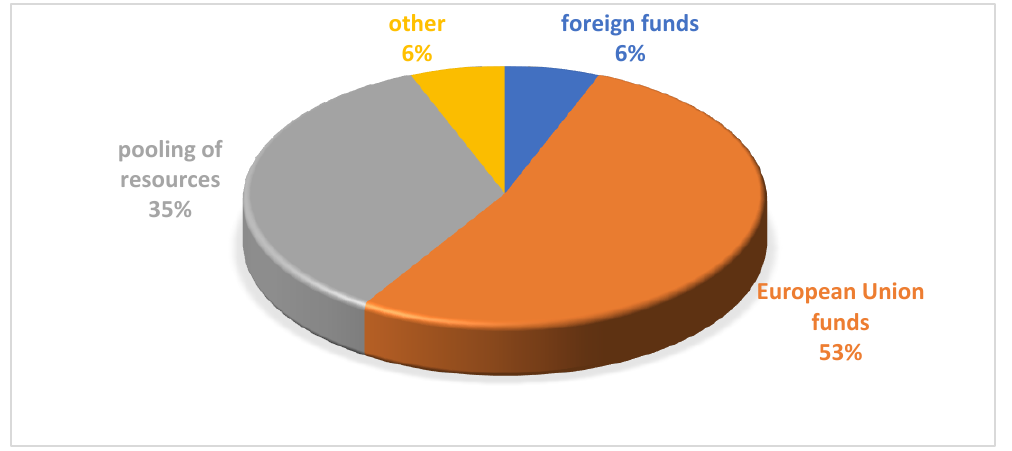
Figure 7. The means by which the goals of a low-carbon economy are achieved.